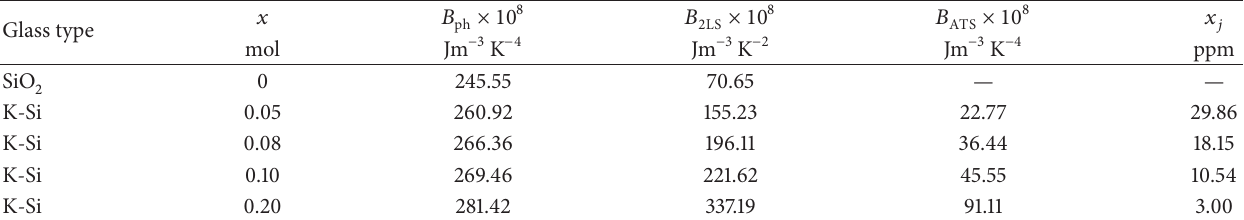
Table 2: Extracted parameters for fits to the heat capacity data for SiO 2 and ( SiO 2 ) 1−𝑥 ( K 2 O ) 𝑥 glasses, with 𝐷 min = 0.87 K and 𝑉 0 = − 0.42K as